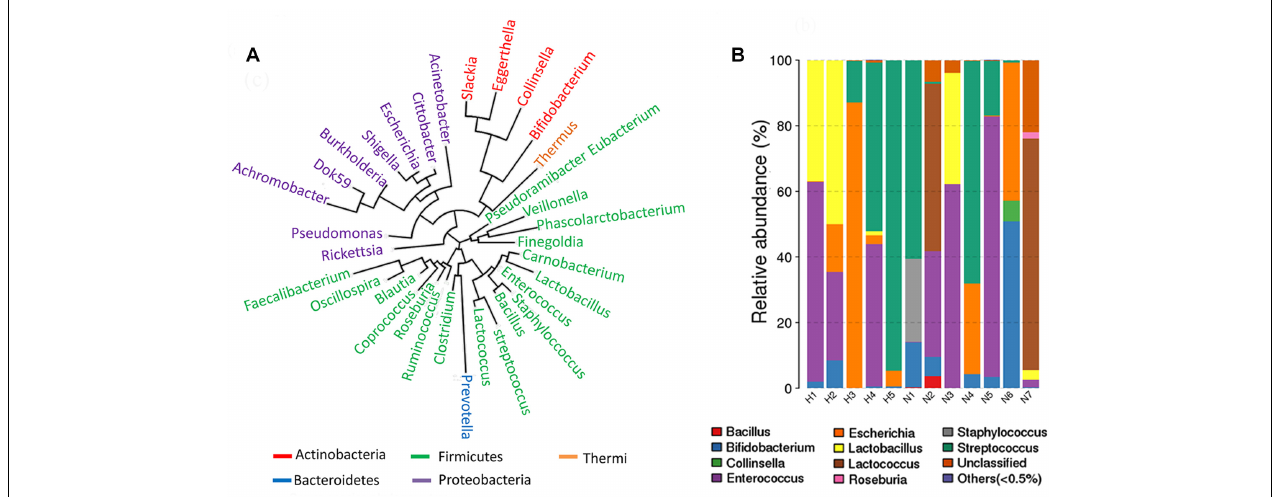
FIGURE 1 | Community structure of IgA-coated bacteria cultured in gut microbiota medium (GMM) and De Man Rogosa Sharpe (MRS) for samples from healthy female donors. (A) A phylogenetic tree was constructed based on MRS and GMM cultured IgA-coated microbiota from 12 healthy female donors. (B) Genus composition of MRS and GMM cultured IgA-coated microbiota from 12 healthy female donors.